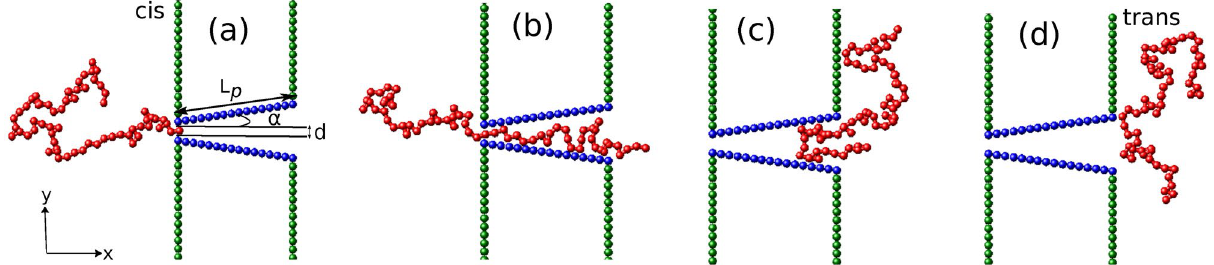
Figure 1. Snapshots from the simulation for various stages of the translocation process of a semiflexible polymer with N = 64 beads, through a conical channel of length L p = 16 σ , half apex angle α and channel entrance width d . ( a ) Equilibrium polymer conformation on the cis side of the channel with one end fixed at the pore entrance. Subsequent polymer conformations, ( b ) midway through the translocation process, ( c ) showing a possible hairpin formation near the channel exit and ( d ) when the polymer has successfully translocated to the trans side of the